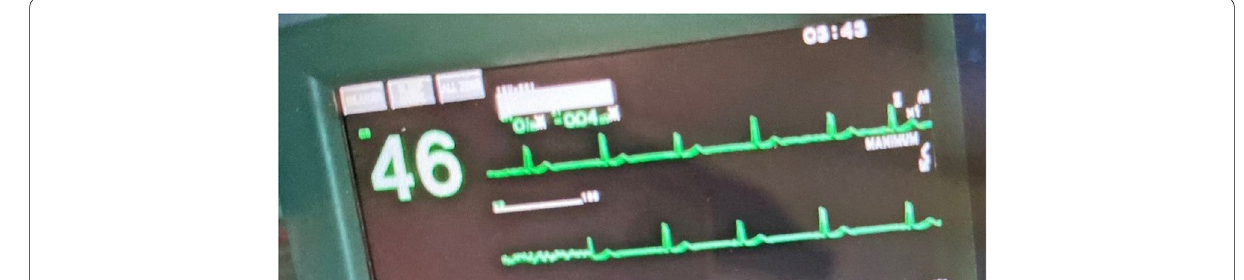
Fig. 1 The patient’s heart rate while awake (46/min)